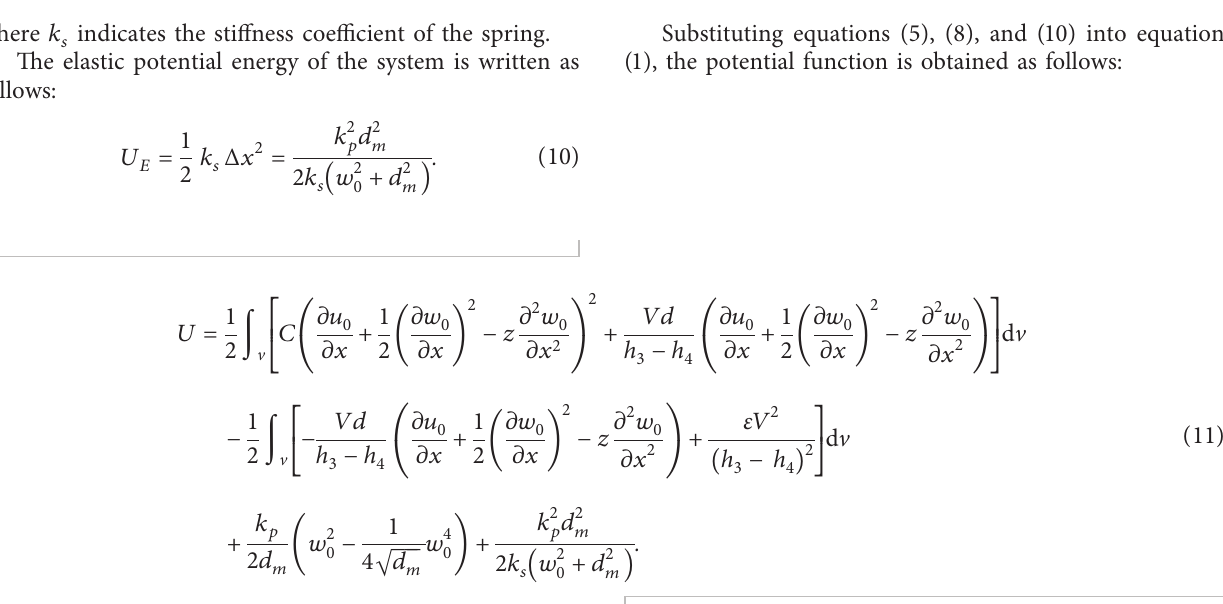
Figure 4: Bistable model and the potential curve of the structure: (a) mechanical model of the structure; (b) the relation of the potential well and the bistable